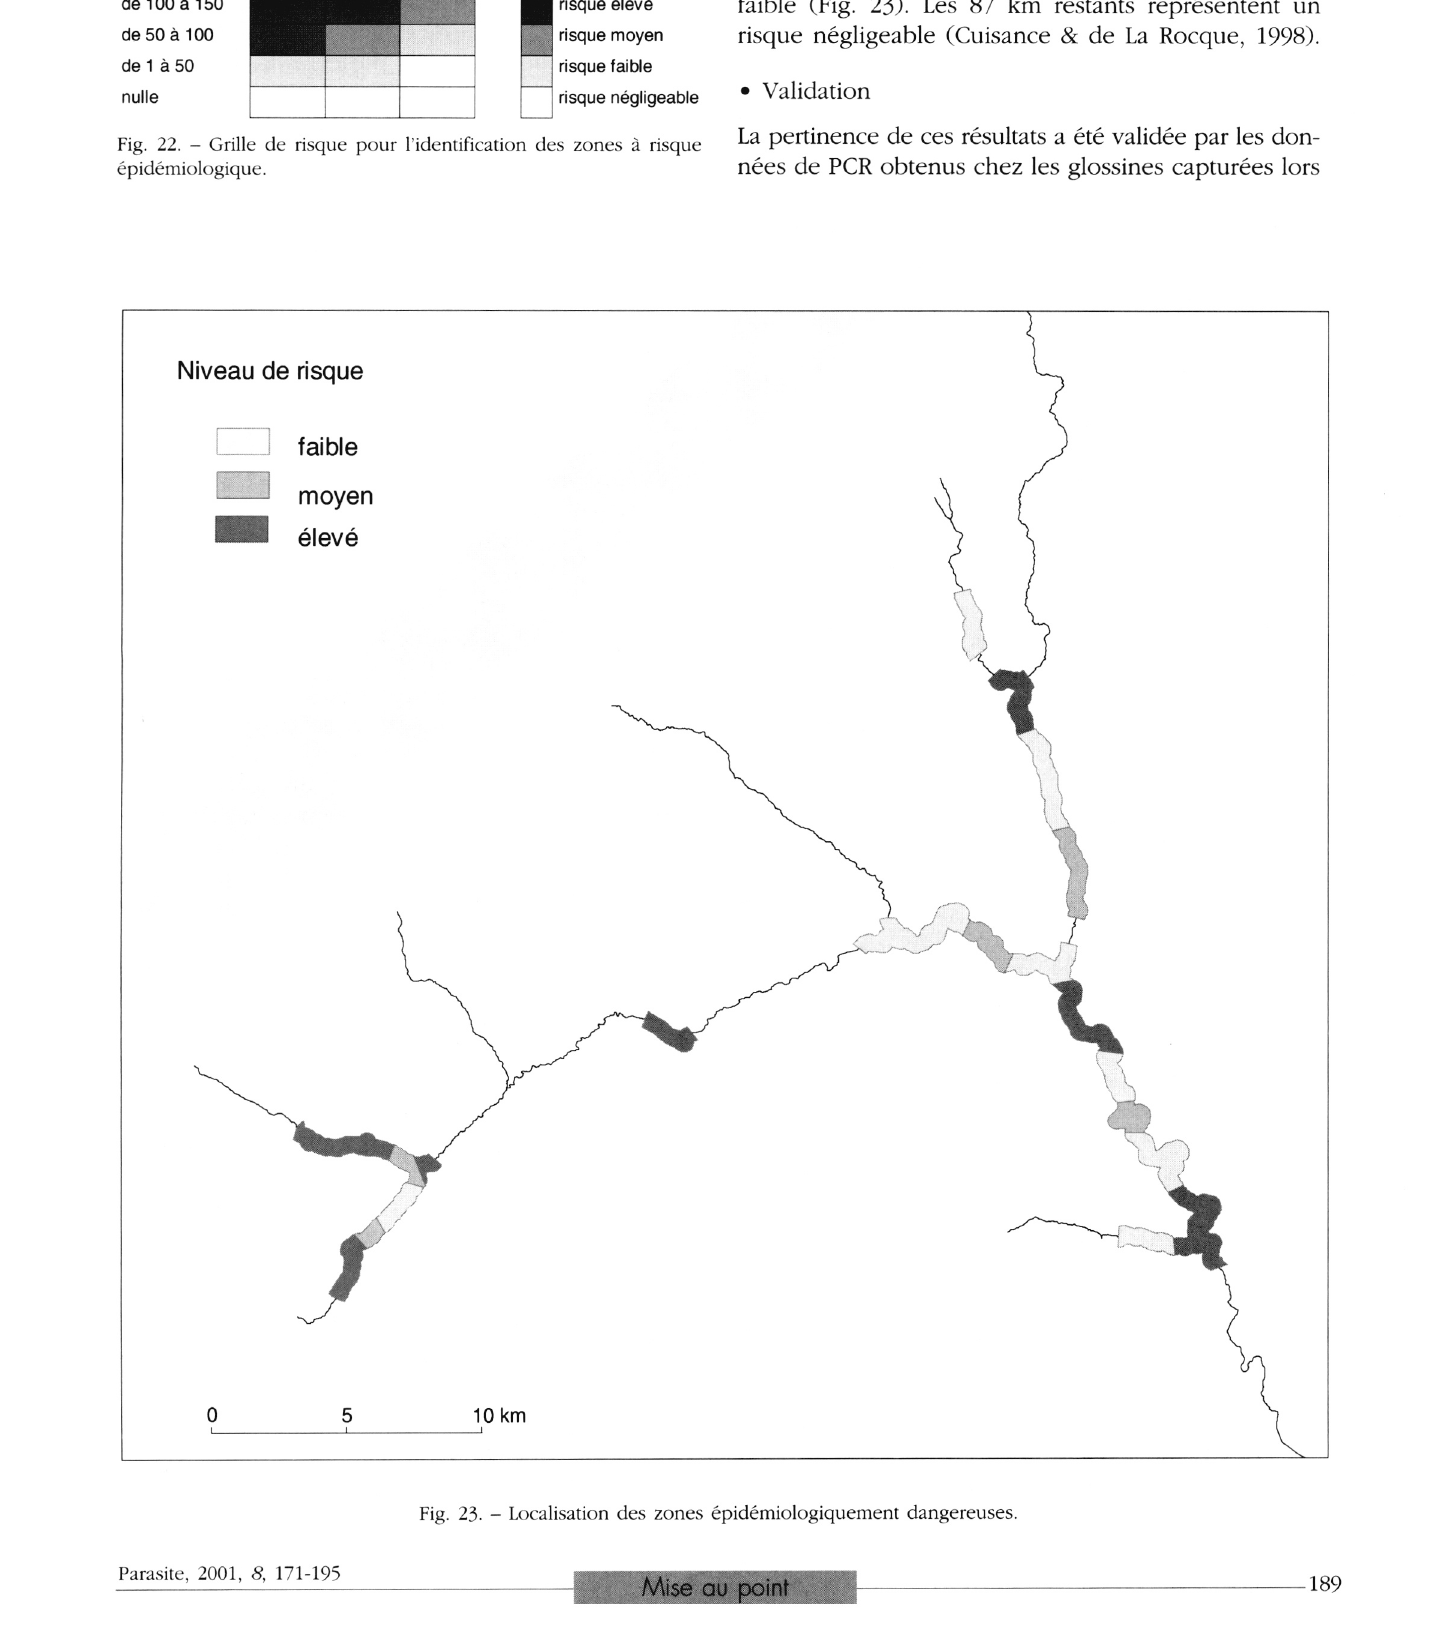
Fig. 22. - Grille de risque pour l’identification des zones à risque épidémiologique.